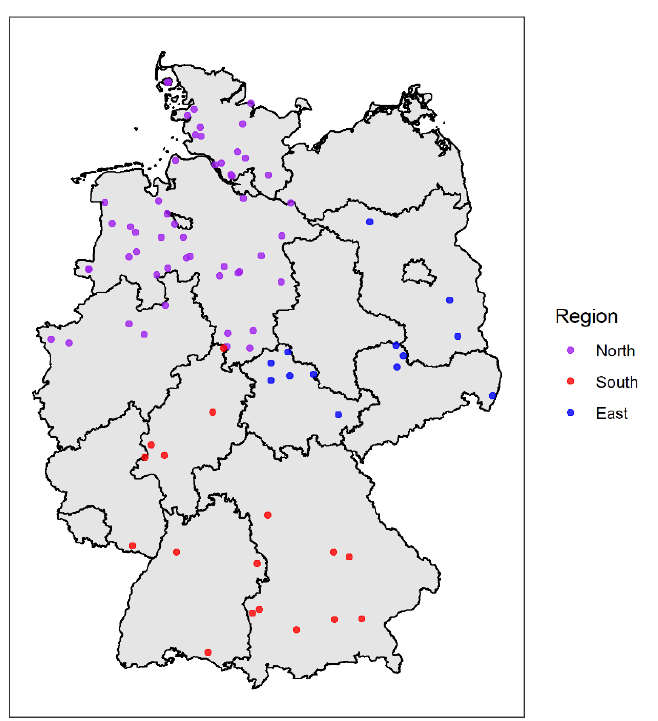
Figure 1. Geographical location of the 83 sheep flocks in Germany from which samples were used to determine the serogroups. Purple: Northern Germany, blue: Eastern Germany and red: Southern Germany.